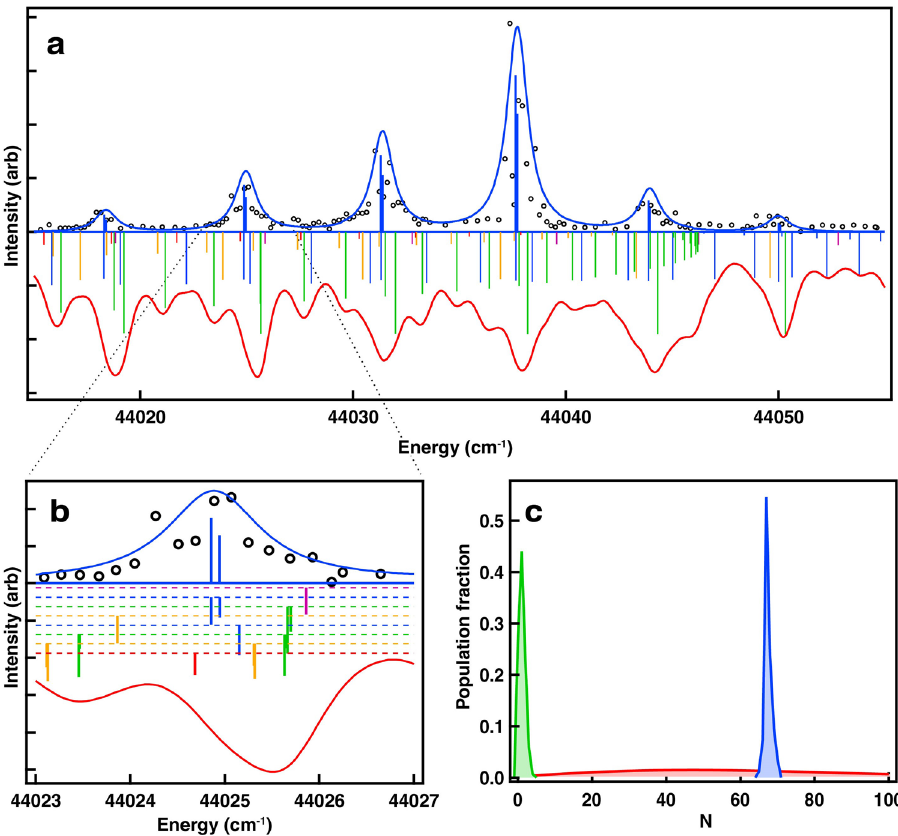
Fig. 3 Optically pumped versus thermal spectra. a Top trace — spectrum of SiO + recorded after pumping toward N = 67, showing resonances from r(65) through r(70); bottom trace — simulated spectrum of a thermal sample at 4600 K. Sticks show underlying rotational structure, color coded according to branch type (see Fig. 2b). b Close view of a region near the r(69) lines. Sticks in the thermal spectrum are vertically offset for clarity. c Rotational populations of the N = 67 ensemble (blue), T = 4600 K thermal sample (red) and T = 3.6 K thermal sample (green).